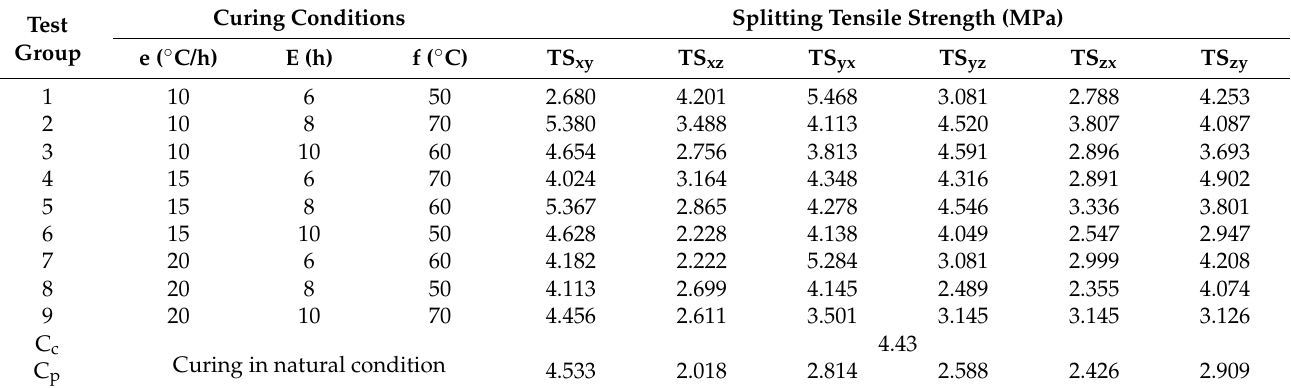
Table 6. Orthogonal experimental table of various test group designs, curing conditions, and splitting tensile strength test data.